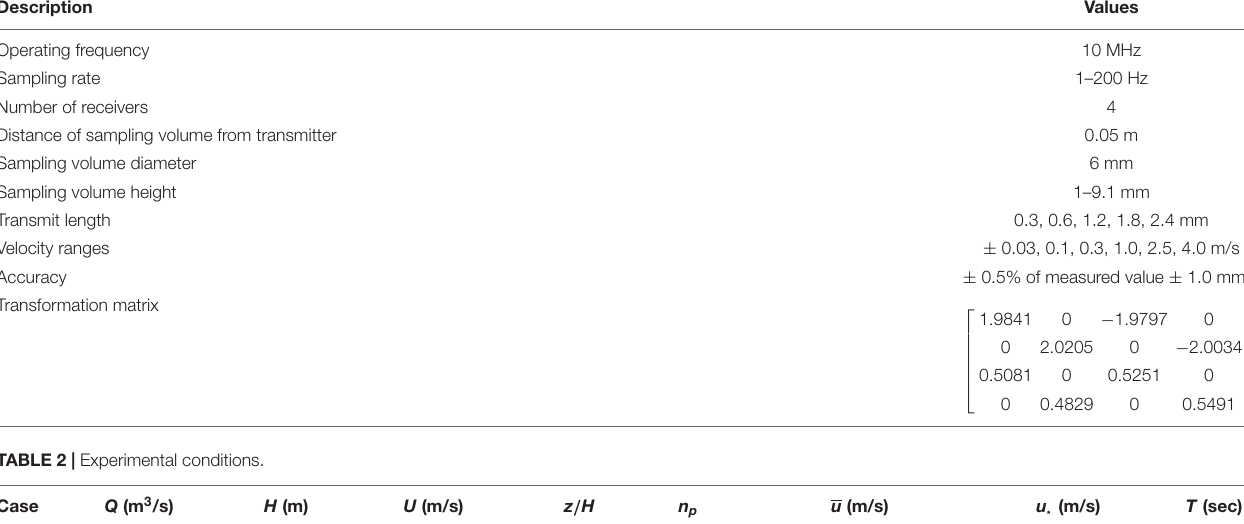
TABLE 1 | Specification of ADV.